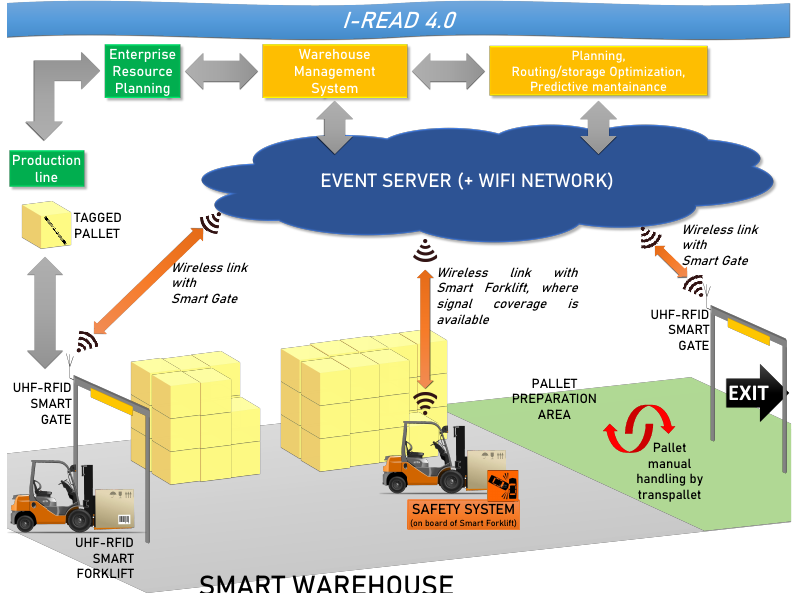
Figure 2. The I-READ 4.0